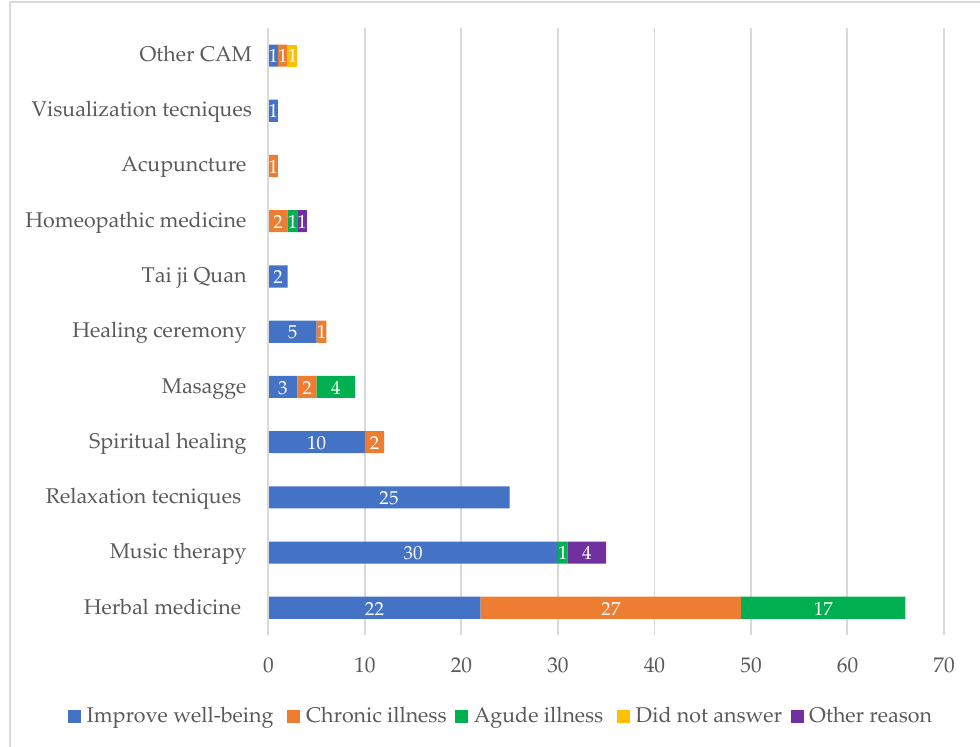
Figure 3. Reasons reported by patients for using complementary and alternative medicine (CAM).